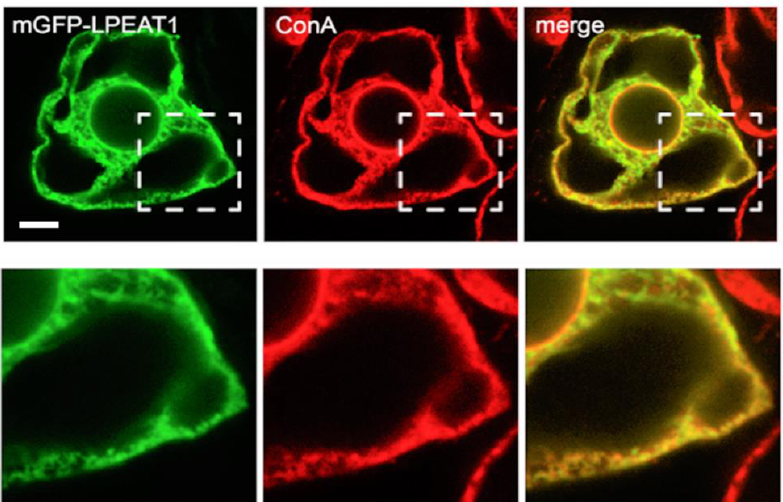
Figure 1. Subcellular localization of Arabidopsis LPEAT1 in BY-2 cells transiently-transformed via biolistic bombardment with mGFP-LPEAT1, formaldehyde-fixed and processed for confocal laser- scanning microscopy (CLSM), including staining with fluorescent dye-conjugated ConA, serving as an ER marker. Shown are representative images, as well as the corresponding merged image; hatch boxes represent the portion of the cell shown at higher magnification in the panels below. The yellow color in the merged image indicates co-localization between mGFP-LPEAT1 (green) and ConA (red) at the ER. Scale bar, 10 μ m.